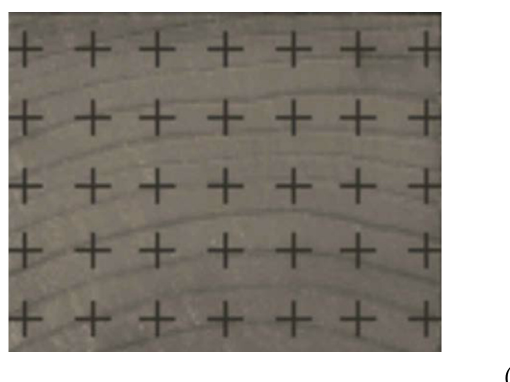
Figure 7. Digital image acquisition device.